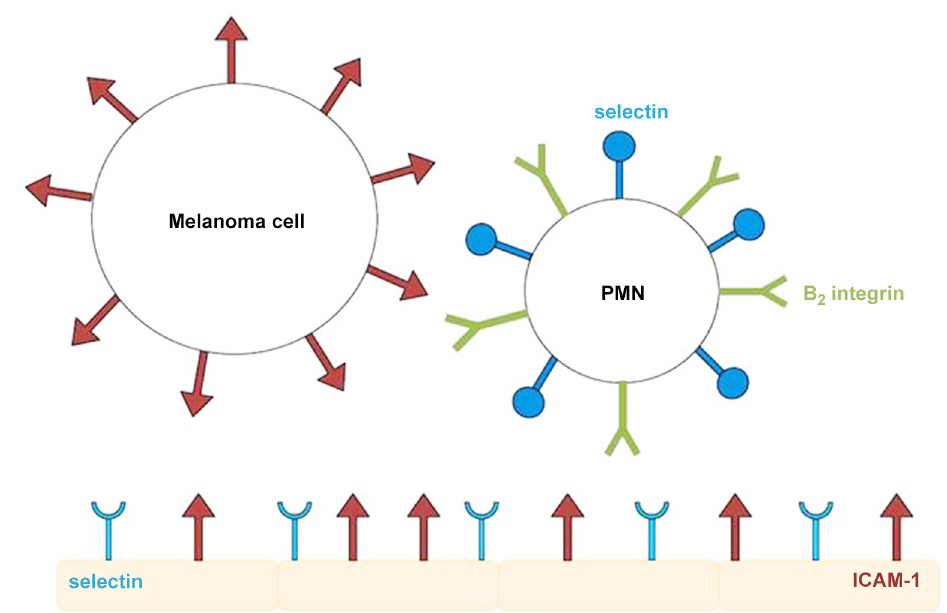
Fig 1. Cartoon of adhesion molecule expression. β -2 integrins expressed on the PMN can interact with ICAM-1 expressed on both the melanoma cell and endothelial cells. The PMN and endothelium can also interact through